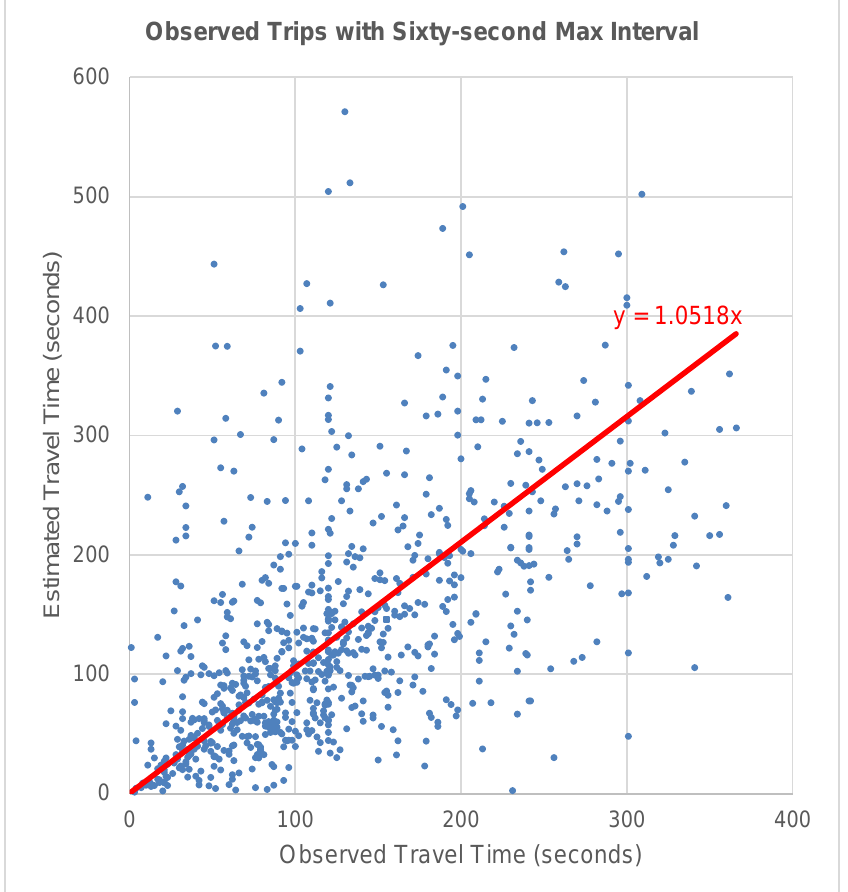
Figure 10. Estimated-observed travel time comparison for trips with 60-seconds max interval